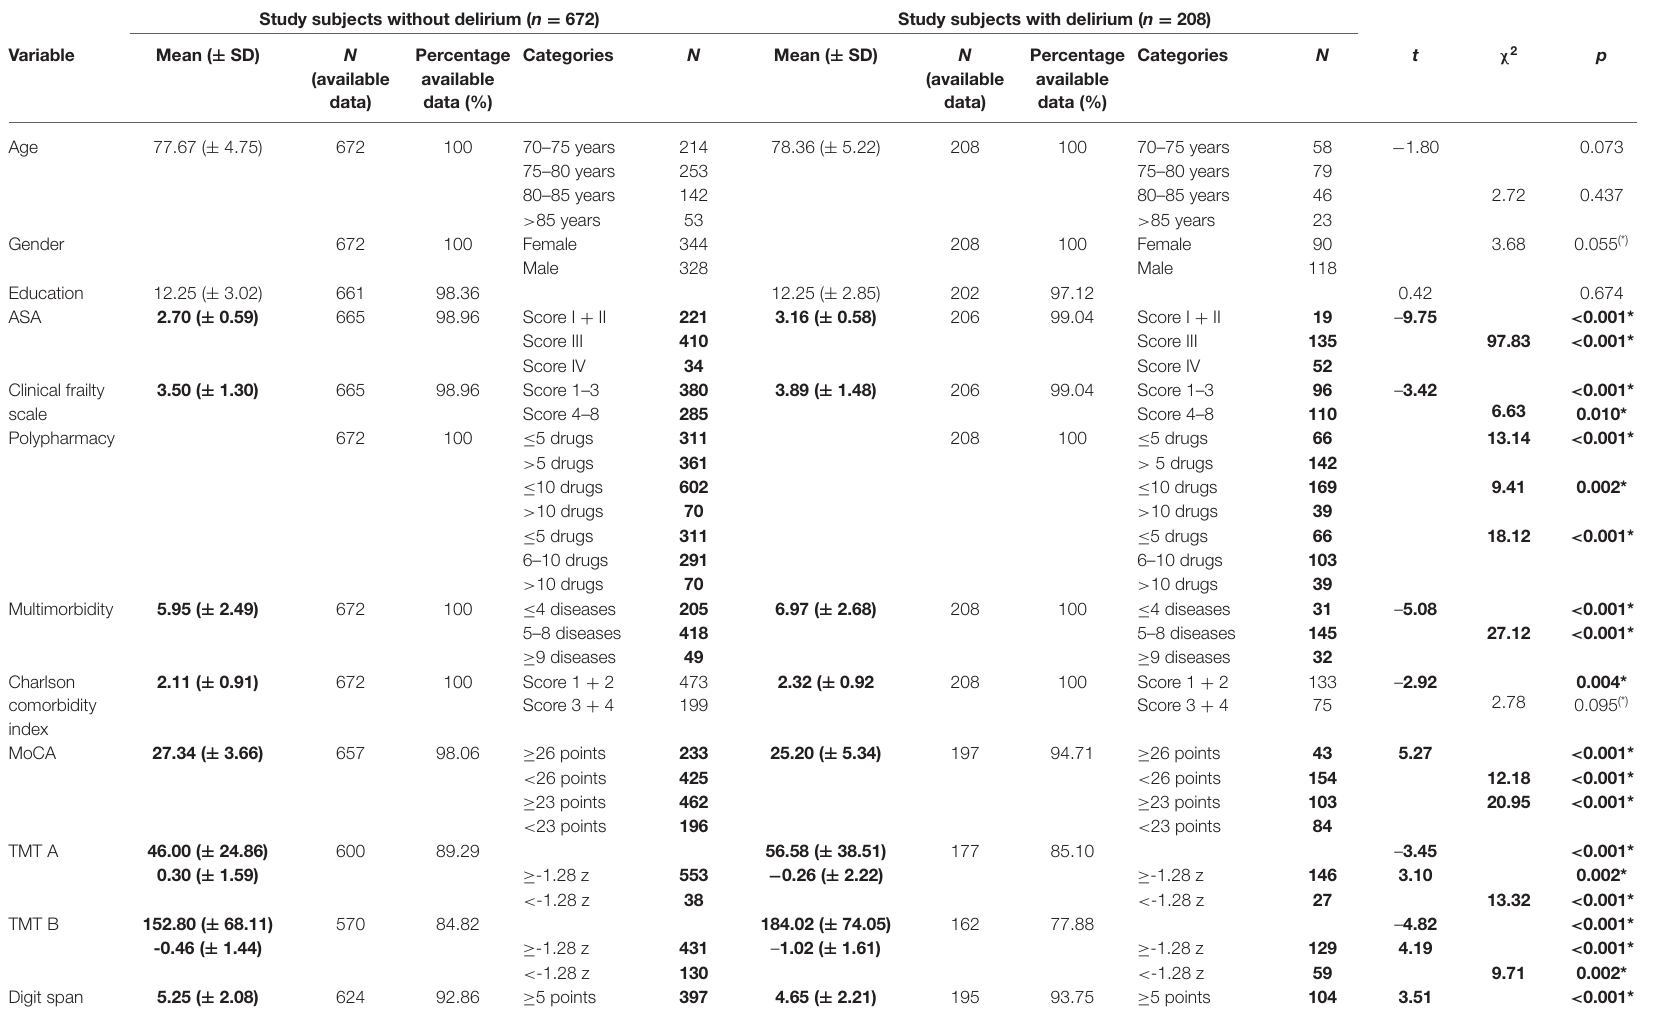
TABLE 2 | Overview and comparison of basic characteristics as a function of